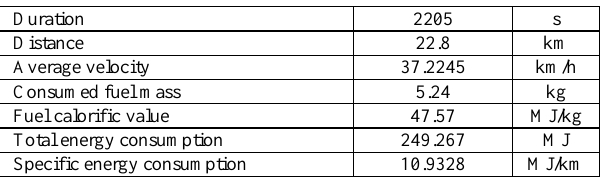
Table 3. Road test data